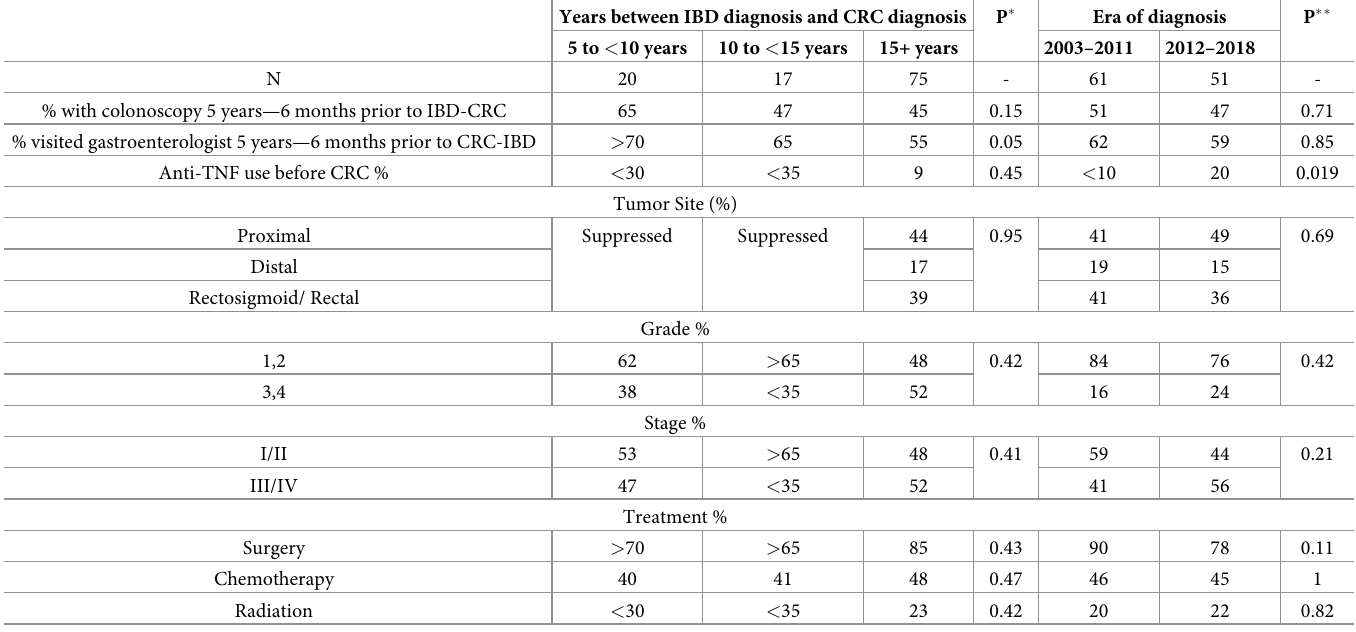
Table 3. Characteristics of IBD-CRC stratified by IBD disease duration prior to CRC diagnosis (CRC